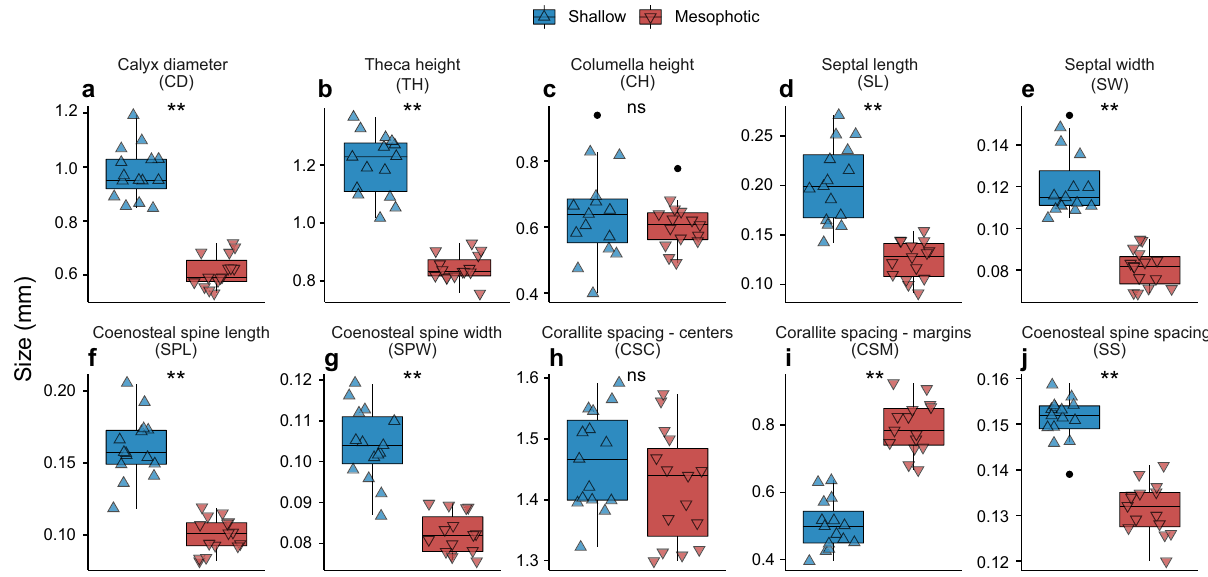
Fig. 2 Morphometric results of S. pistillata ’ s skeletal traits. a – j Box plots showing the mean size variation of morphometric traits between shallow (blue; triangle point up) and mesophotic (red; triangle point down) S. pistillata colonies ( n = 30). Horizontal lines depict the median, box height depicts the interquartile range, whiskers depict ±1.5× interquartile range, and dots represent outliers. Asterisk denotes signi fi cance ( p < 0.01).